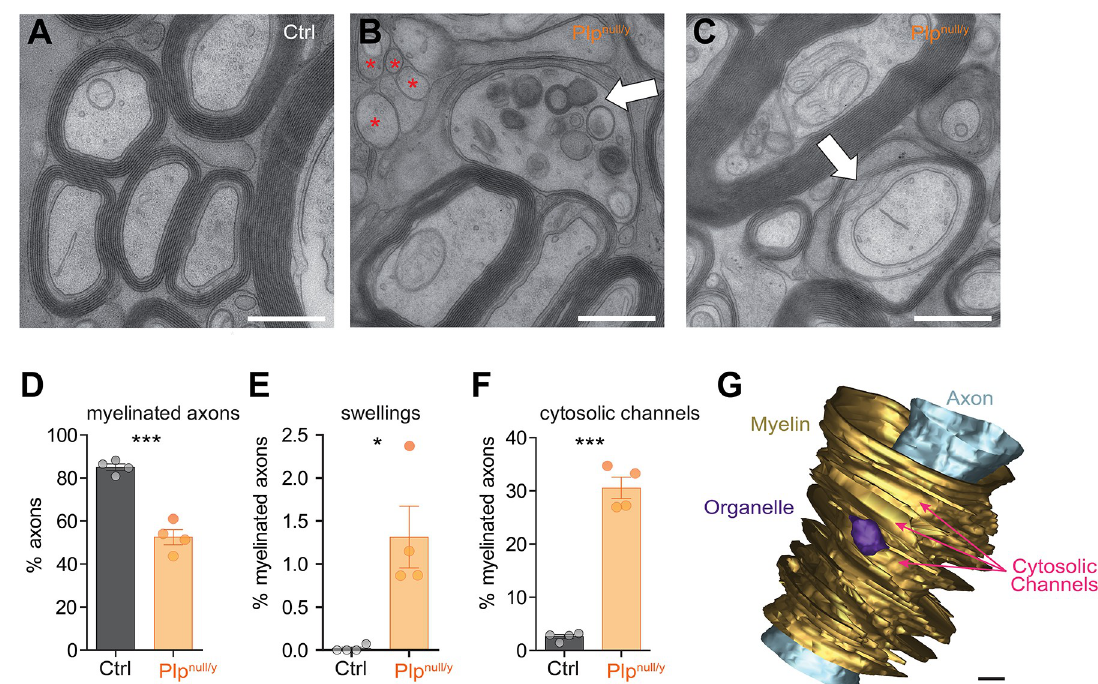
Fig 5. Structure of myelin in Plp null/y optic nerves. (A–C) Electron micrographs of high-pressure frozen optic nerves of a 10-week-old control (Ctrl) (A) and Plp null/y (B and C) mouse. Asterisks indicate unmyelinated axons; white arrows highlight an axonal spheroid (B) and cytosolic channels (C). The scale bars correspond to 500 nm. (D) Genotype-dependent quantification of the number of myelinated axons in optic nerves dissected from Ctrl and Plp null/y mice; 100% refers to all axons. (E) Genotype-dependent quantification of the percentage of axon–myelin units comprising axonal swellings; 100% refers to all myelinated axons.(F) Genotype-dependent quantification of the percentage of axon–myelin units with myelin containing cytosolic channels; 100% refers to all myelinated axons. In (D–F), n = 4 and 4 nerves from N = 4 and 4 mice for Ctrl and Plp null/y , respectively. � p < 0.05, ��� p < 0.001; Student t test. (G) 3D rendering of the structure of an axonal segment and the inner layers of the myelin sheaths obtained using focused ion beam scanning electron microscopy (FIB-SEM). For simplicity, the outermost layer of myelin is not visualized in the 3D reconstruction. Cytosolic channels are colored yellow, the axon is in light blue, and organelle-like structures are in purple. The scale bar corresponds to 200 nm. See S1 Movie for an animated visualization of this 3D structure. Data underlying this figure can be found in S1 Data.